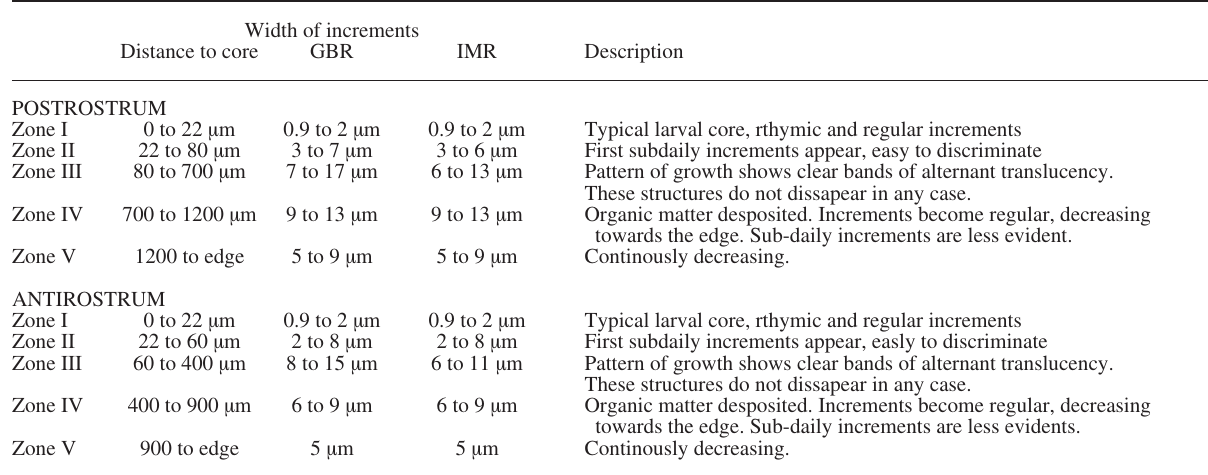
Table 1. – Characteristics of the five zones in the sagittal otolith of European anchovy.